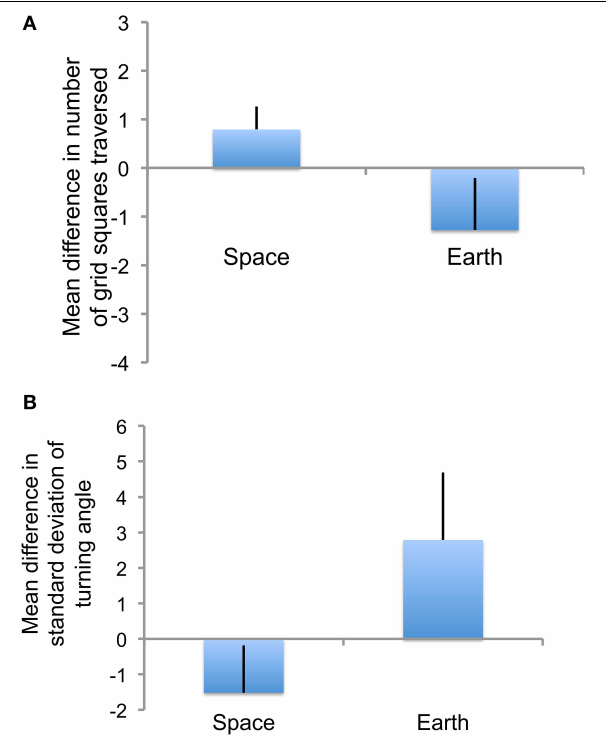
TABLE 1 | Mean number of ants per 9.2mm grid square.